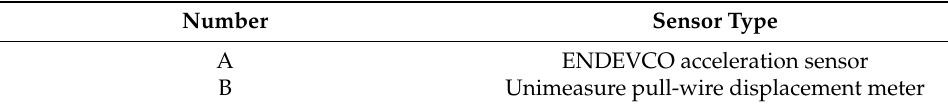
Table 2. Sensor layout of simulated seismic shaking table